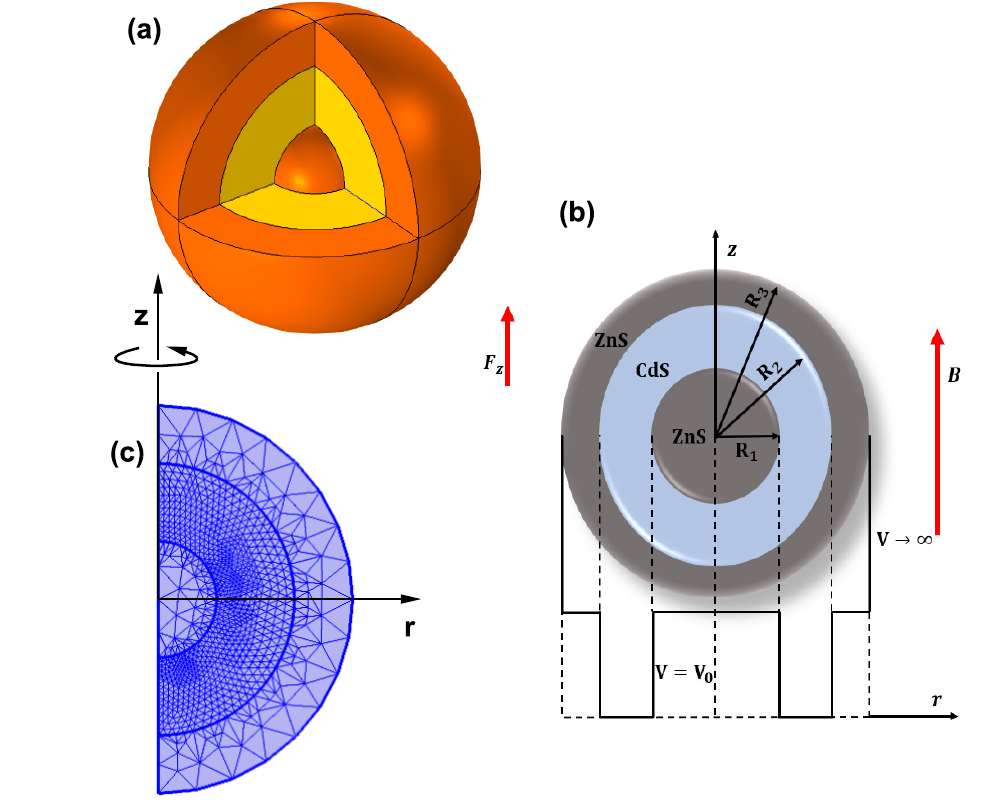
Figure 1. ( a ) ZnS/CdS/ZnS spherical quantum dot heterostructure considered in this work. In ( b ), the dimensions of the quantum dot and the applied axial electric and magnetic field are indicated together with the radial dependent confinement potential. In ( c ) is depicted the ϕ = 0-projection of the heterostructure (where cylindrical coordinates are considered) together with the refined mesh used in the finite element method